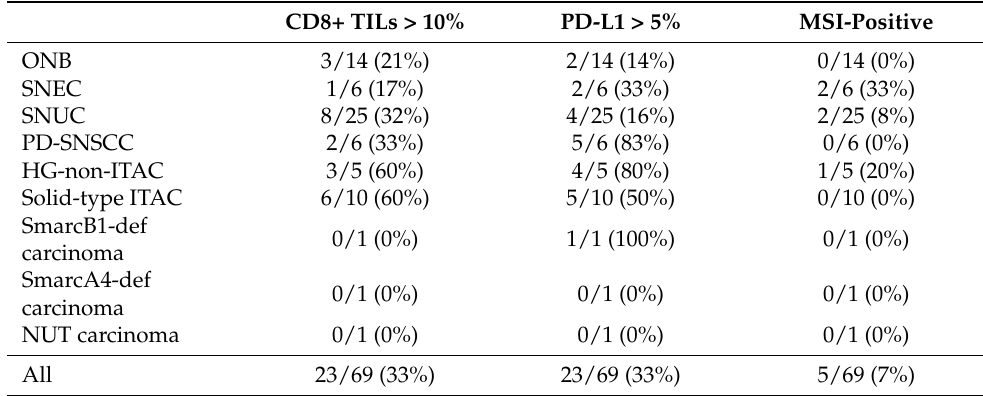
Table 2. CD8+ TILs, PD-L1 and MSI scores according to tumor